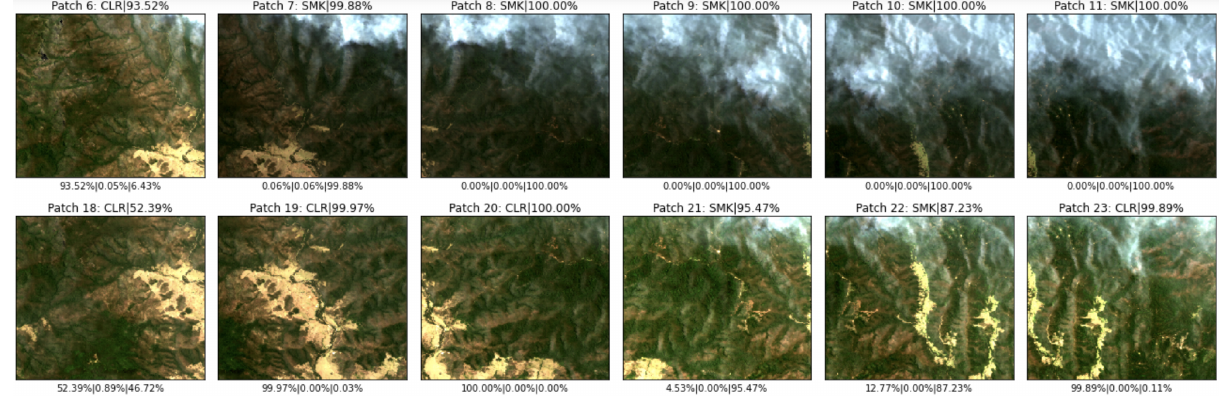
Figure 13. Prediction results of the top right fire smoke area of scene (d) in Figure